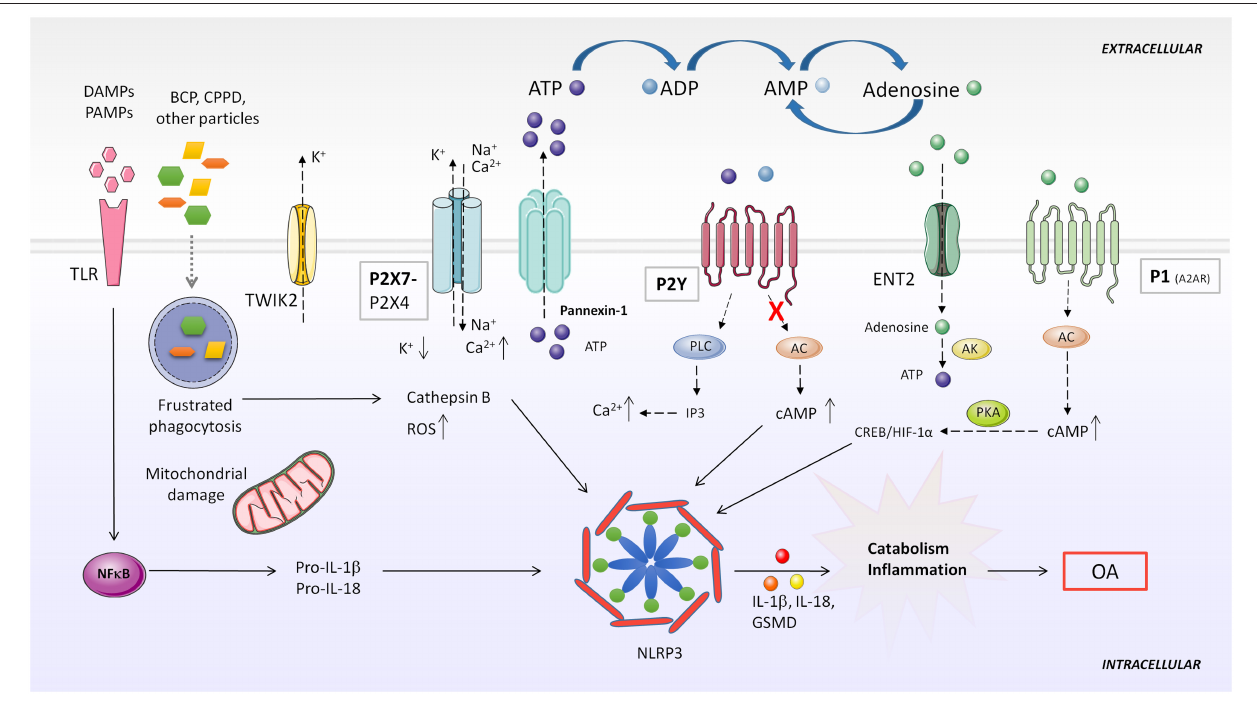
FIGURE 4 | Purinergic system implication in NLRP3 inflammasome activation. DAMPS or PAMPs present in the microenvironment are recognized by TLR receptors, which in turn, upregulate pro-IL-1 β and pro-IL-18 expression through NF- κ B activity. BCP and CPPD crystals can be both recognized by TLRs and phagocytized by the cell. Impaired particle or crystal phagocytosis by phagosomes leads to cathepsin B release and mitochondrial dysfunction, which induce elevated ROS production and consequent NLRP3 activation. Additionally, frustrated phagocytosis can lead to massive ATP release through Pannexin-1, activatingP2X7 and causing ionic cytoplasmic imbalance. Excessive K + efflux, especially through TWIK2, and Na + and Ca 2 + influx through P2X7 activates NLRP3 inflammasome. Activation of different P2Y by ATP or ADP increases intracellular Ca 2 + concentration. Particles can also impede induction of purinergic AC-cAMP pathway allowing NLRP3 activity. A2AR activation by extracellular adenosine induces HIF-1 α upregulation, which activates NLRP3. AC, adenylate cyclase; AK, adenosine kinase; BCP, basic calcium phosphate; CPPD, calcium pyrophosphate dehydrate; DAMP, danger-associated molecular patterns; ENT2, equilibrative nucleoside transporter 2; GSMD, gasdermin D; IP3, inositol 1,4,5-trisphosphate; NLRP3, NOD-like receptor pyrin domain containing 3; PAMP, pathogen-associated molecular patterns; PKA, protein kinase A; PLC, phospholipase C; ROS, reactive oxygen species; TLR, toll like receptor; TWIK2, two-pore domain weak inwardly rectifying K + channel